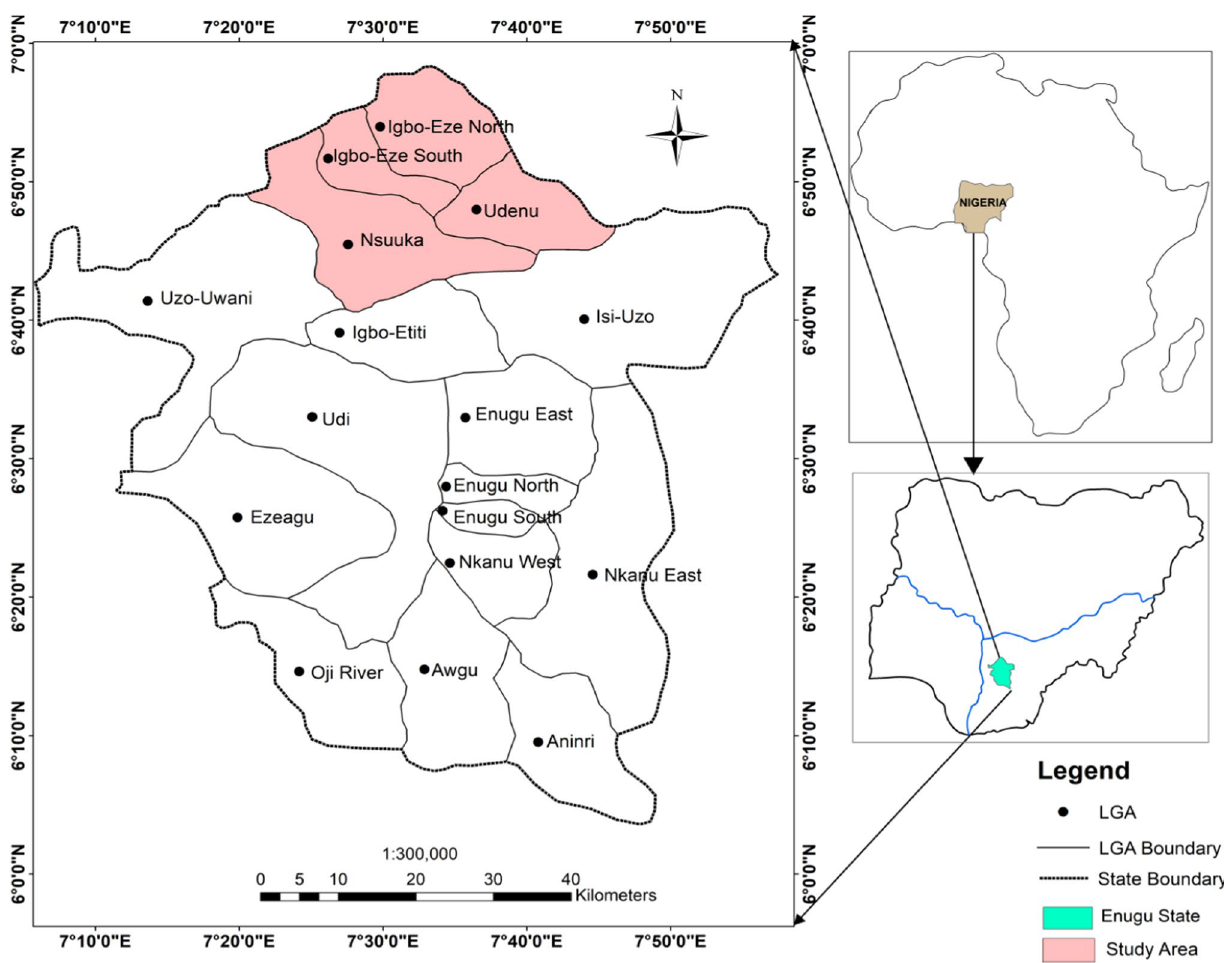
Fig. 1 Map showing the location of the study